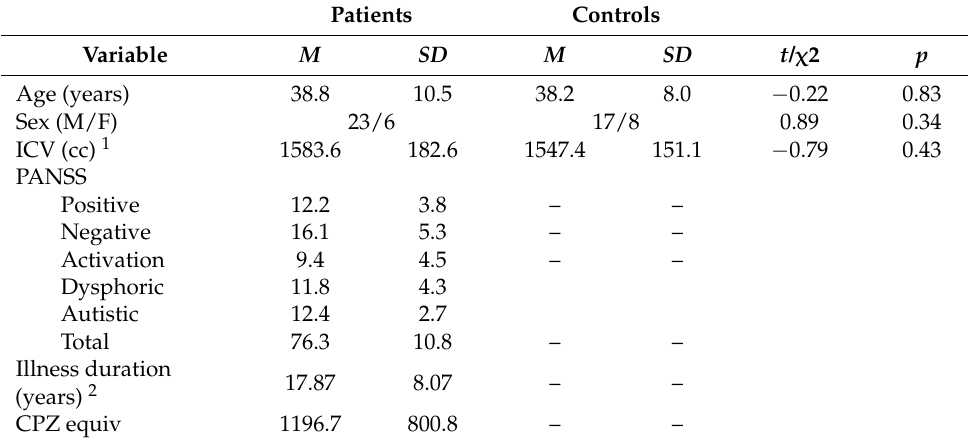
Table 1. Demographic data for the